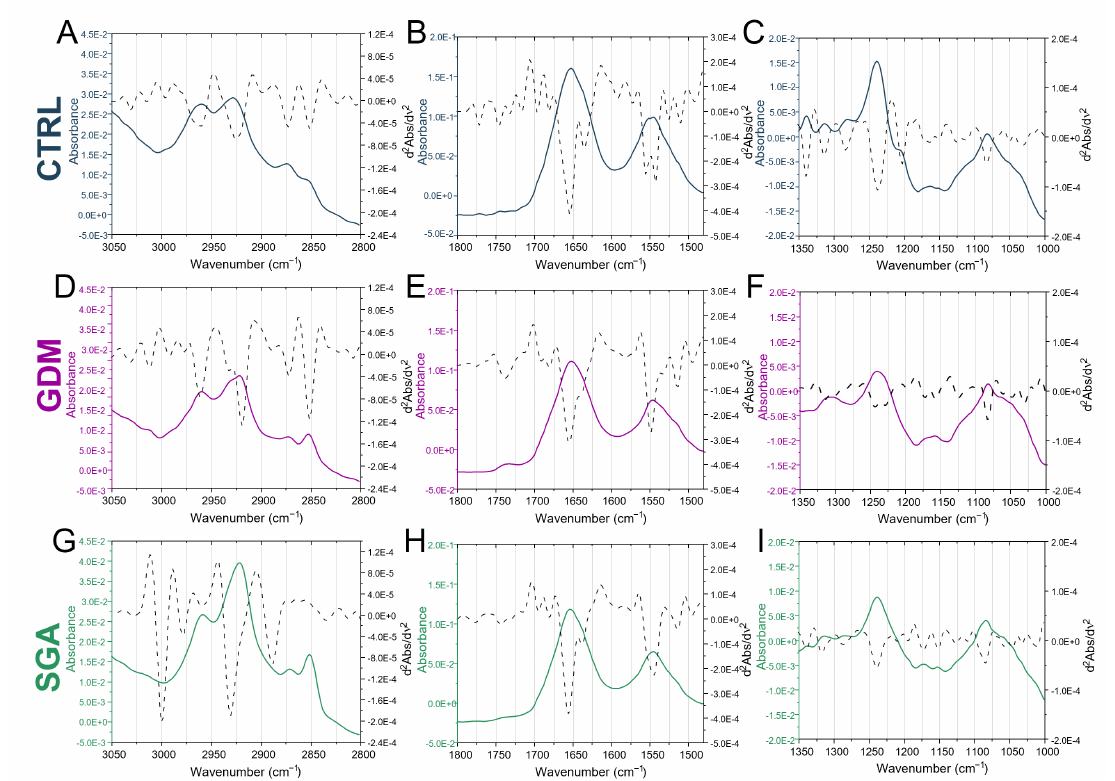
Figure 2. Vibrational analysis. Mean infrared spectra of control (CTRL, blue lines), gestational dia- betes mellitus (GDM, purple lines), and small-for-gestational-age (SGA, green lines) samples. Spectra are displayed in absorbance (colored continuous lines) and second derivative modes (black dotted lines) in the 3050–2800 cm − 1 ( A , D , G ), 1800–1480 cm − 1 ( B , E , H ), and 1350–1000 cm − 1 ( C , F , I ) intervals. To have a deeper insight into the spectral changes triggered by GDM and SGA in the CVs, spectral data were then submitted to Principal Component Analysis (PCA) in the following ROI (Regions of Interest): 3050–2800 cm − 1 , 1800–1480 cm − 1 , and 1350–1000 cm − 1 (Figure 3). The segregation between CTRL and GDM spectral data and CTRL and SGA spectral range 1350–1000 cm − 1 (Figure 3C,F,I,L).